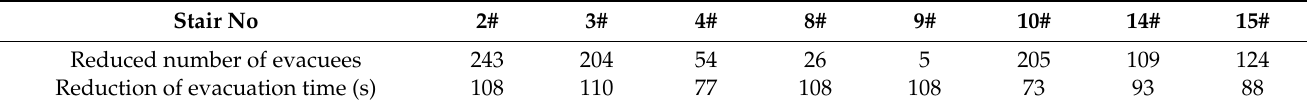
Table 7. Reduction of evacuation number and evacuation time of each